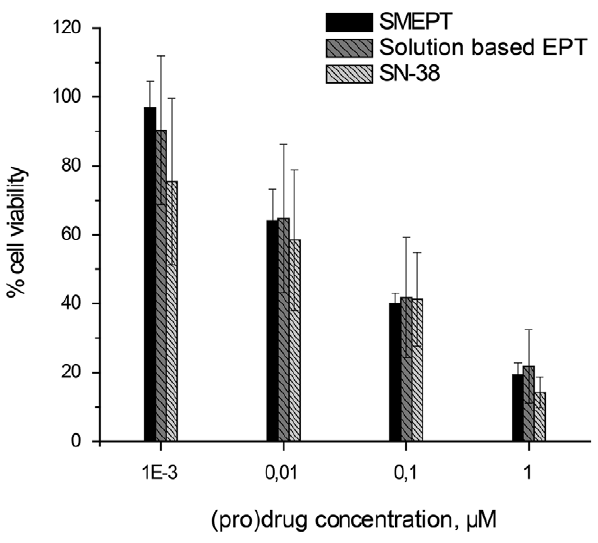
Figure 8. Dose response for HepG2 cells to the administered SN-38 glucuronide (for SMEPT and solution based EPT) or SN- 38. Presented results (mean 6 st.dev.) are average over at least 3 independent experiments, 3 replicates